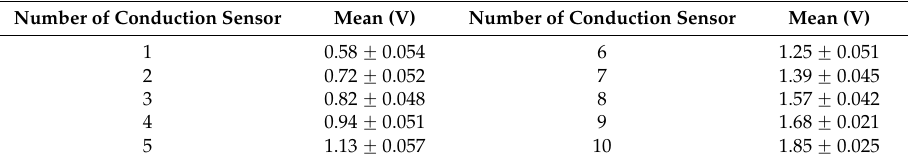
Table 1. Statistical analyses results of the same sensing point weight ratio ( N = 10).